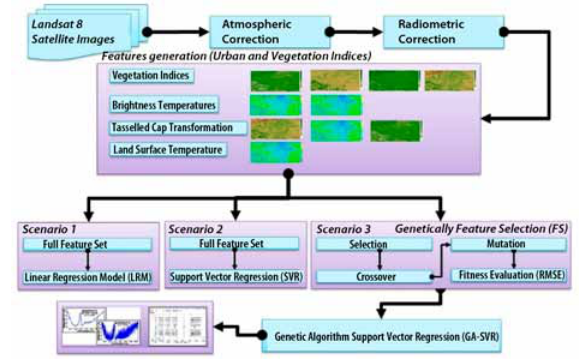
Fig. 1. Flowchart of proposed